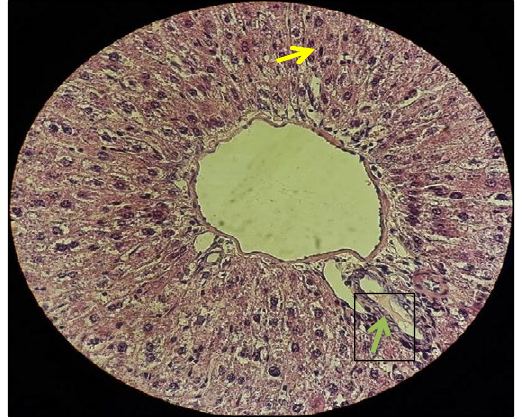
Fig. 4. Photomicrograph of rat liver tissues in the Fig. 5: Photomicrograph of rat liver tissues in the Figure 4. Photomicrograph of rat liver tissues in the control group. In this group, the hepatic tissues Fig. 5: Photomicrograph of rat liver tissues in the experimental group 1. In this group, there was a control group. In this group, the hepatic tissues appear experimental group 1. In this group, there was a slight change appear completely normal and do not show cellular damaging. All hepatocytes are healthy. slight change relative to the control group. Necrosis is shown with a yellow arrow, and cellular relative to the control group. Necrosis is shown with a yellow completely normal and do not show cellular damaging. arrow, and cellular congestion is indicated by a green arrow. All hepatocytes are healthy. (Hematoxylin-eosin staining, (Hematoxylin-eosin staining, magnification 400×). congestion is indicated by a green arrow. (Hematoxylin-Eosin staining, magnification 400 ×). magnification 400×). (Hematoxylin-Eosin staining, magnification 400